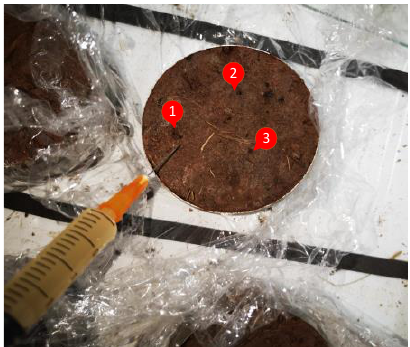
Figure 2. Schematic diagram of undisturbed root – soil composite grouting. (The numbers 1,2 and 3 indicate the injection location in the figure.)